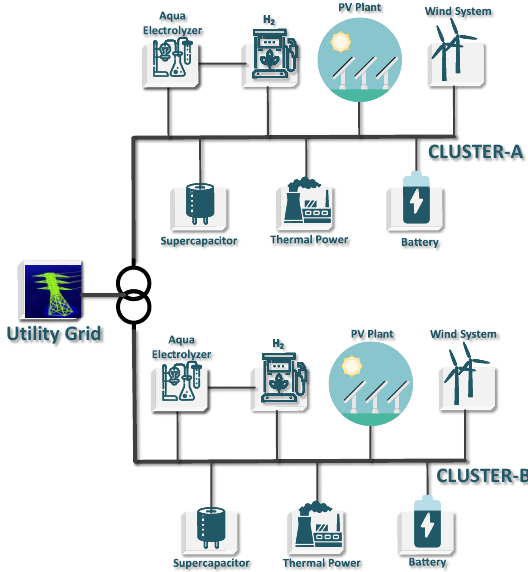
Figure 1. Conceptual diagram of microgrid